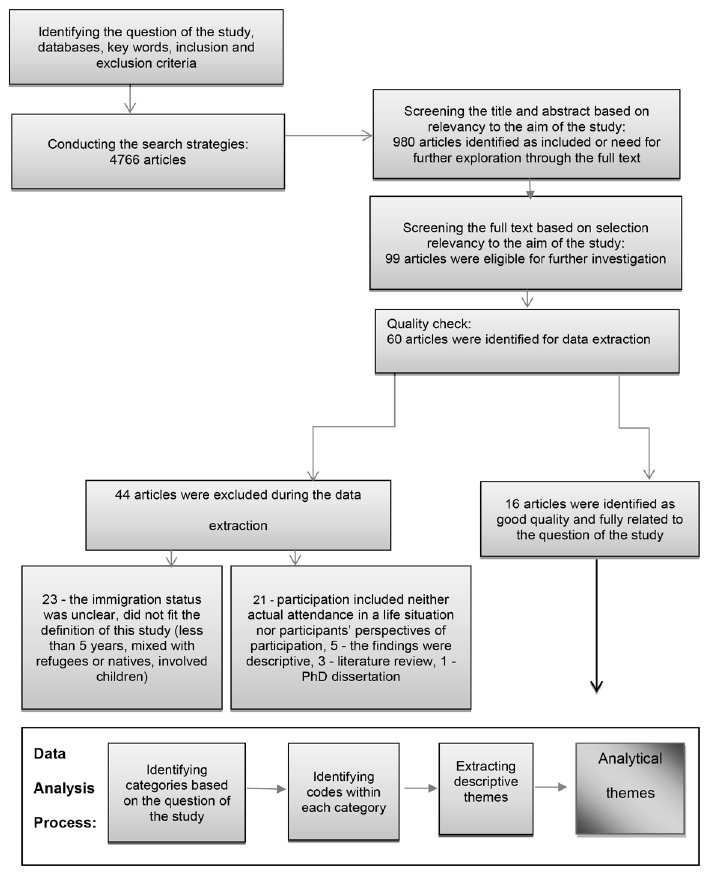
Figure 1. Identification, Eligibility and, Inclusion Process of the Research